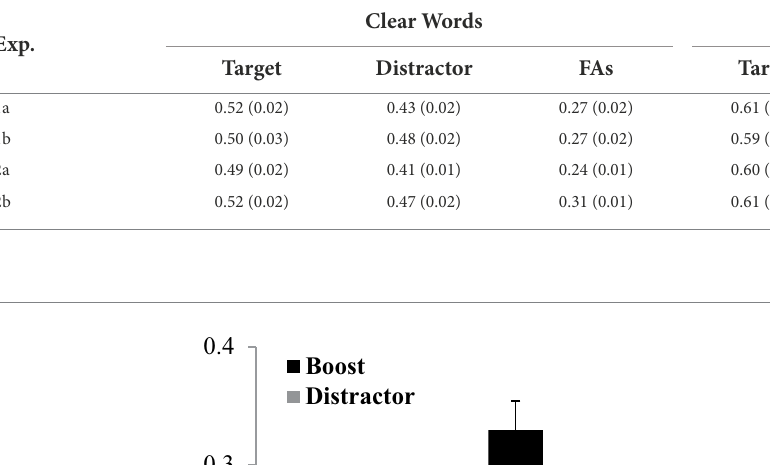
computed for each condition and submitted to separate repeated measures analyses of variance (ANOVA) for each experiment. The ANOVAs treated perceptual degradation (clear/blurry) and boost signal (target/distractor) as within- participant factors. Mean corrected hits for each condition are plotted in Figure 2.